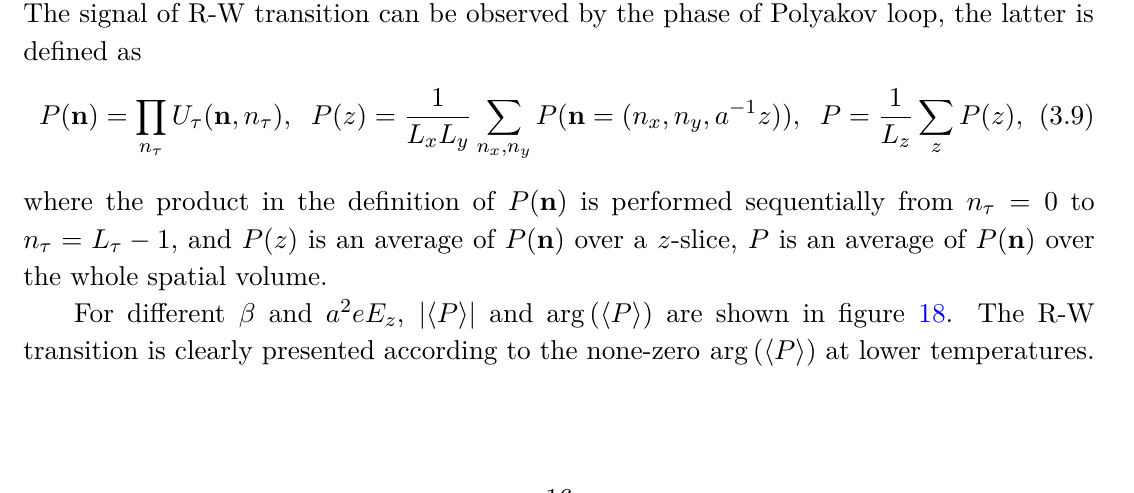
Figure 16 . Same as figure 6 but for Im